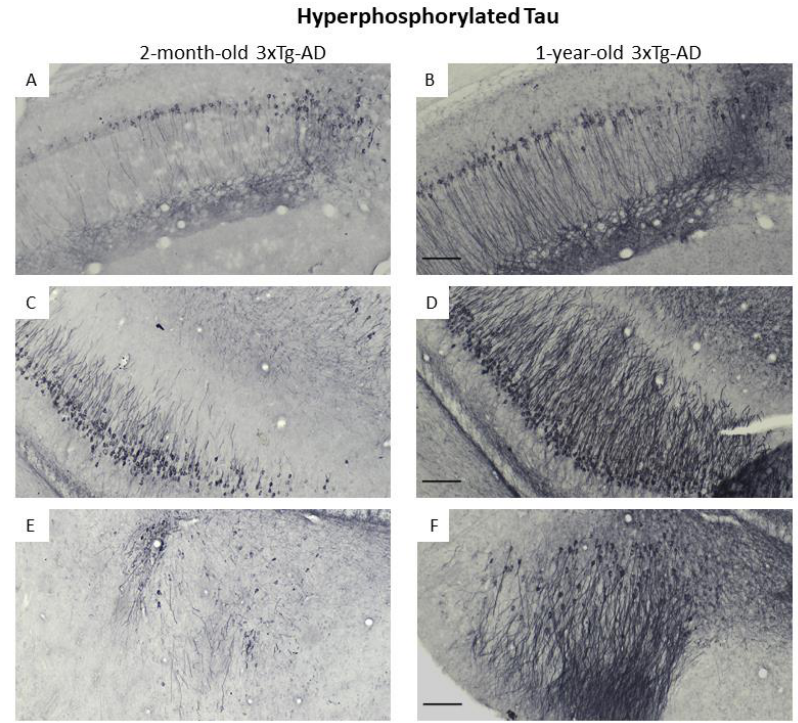
Figure 7. Phospho-Tau tangles stained with Ni-DAB immunohistochemistry in 2-month-old and 1-year-old 3xTg-AD mice. The images show different brain areas, like: pyramidal cell layer in the CA1 region of the hippocampus ( A , B ), pyramidal cell layer in the CA3 region of the hippocampus ( C , D ) and basolateral amygdaloid nucleus, amygdalopiriform area and entorhinal cortex ( E , F ). Scale bar is 100 μm .